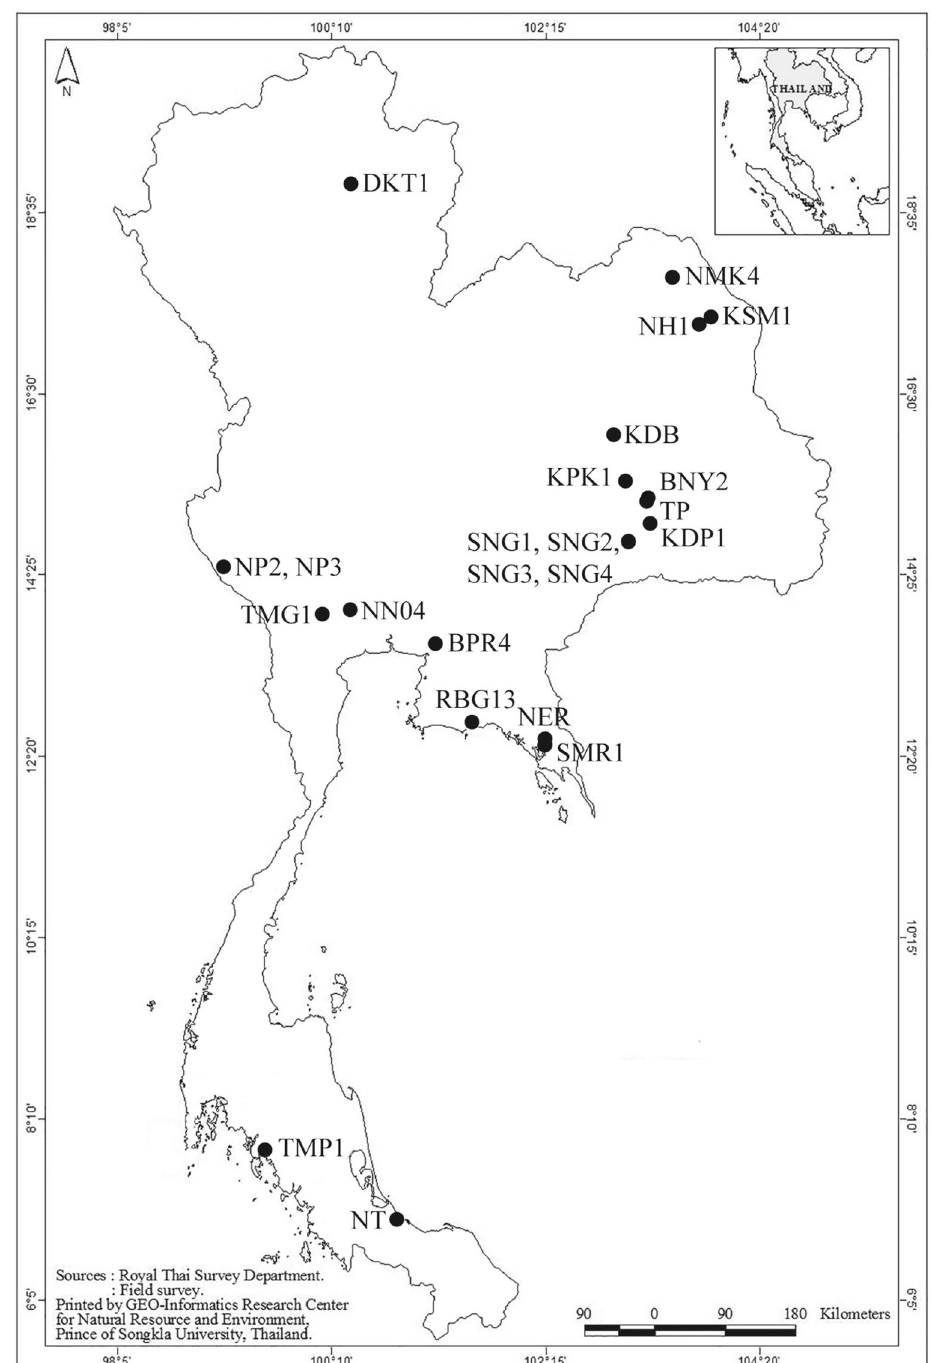
Figure 1. Sampling sites of the analyzed Tropodiaptomus samples. Refer to Table 1 for locality codes. (This map was created by GEO-Informatics Research Center for Natural Resource and Environment, Prince of Songkla University and modified by authors with Adobe Illustrator